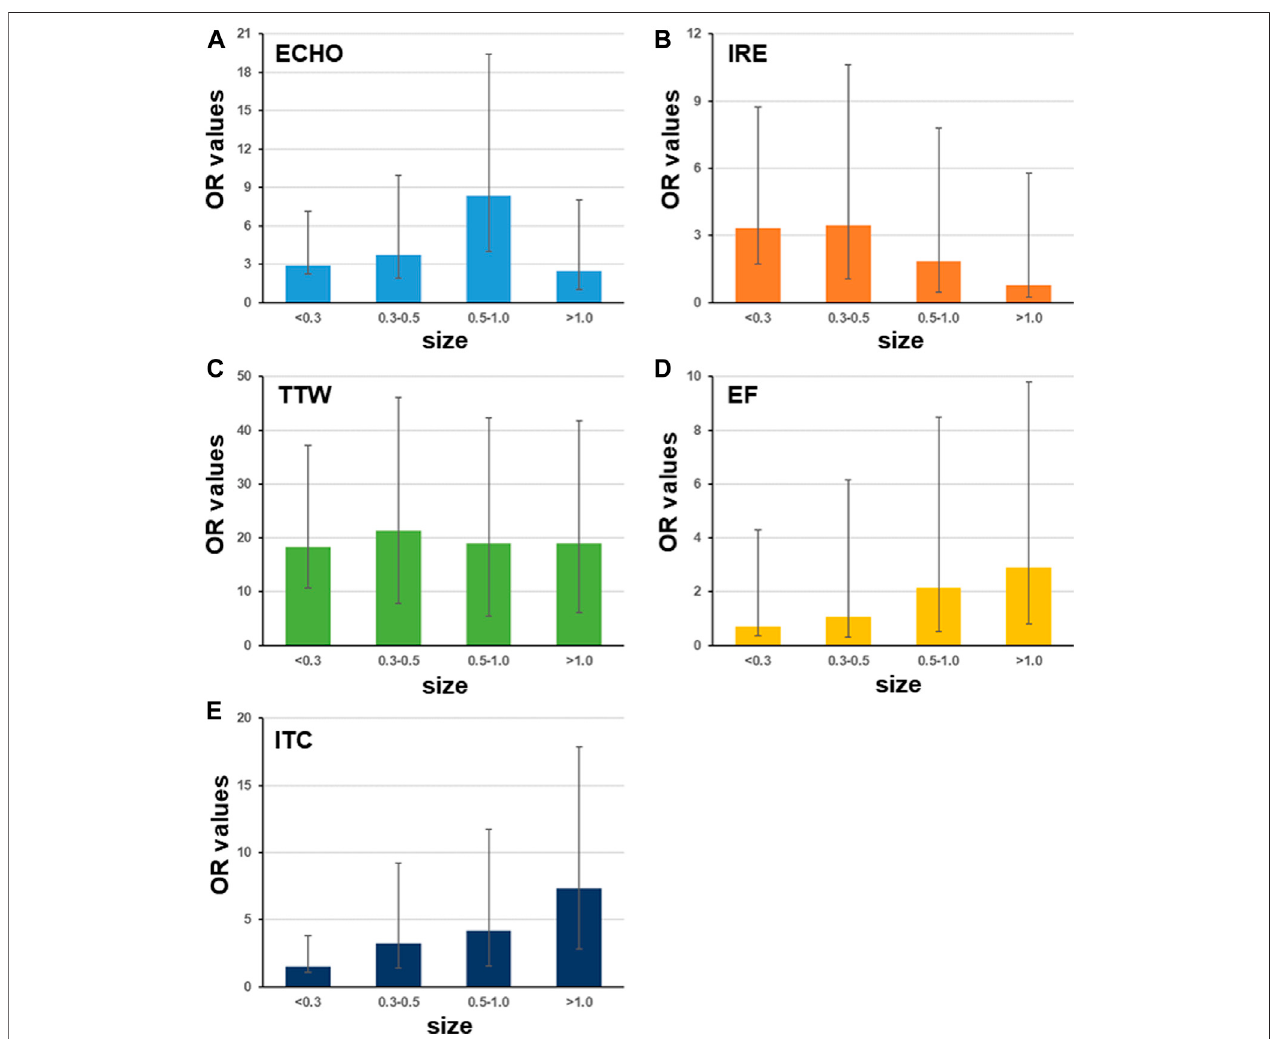
FIGURE 1 | Odds ratio of ultrasound characteristics differs with nodule size. The patients are classi fi ed into groups with different nodule sizes including < 0.3 cm, 0.3 – 0.5 cm,0.5 – 1 cm,and > 1 cm(samplesizeis33,187,499,and281,respectively).Among fi veultrasoundcharacteristics,onlyfourhaveORvalueswithsigni fi cance < 0.05. Bars indicate the